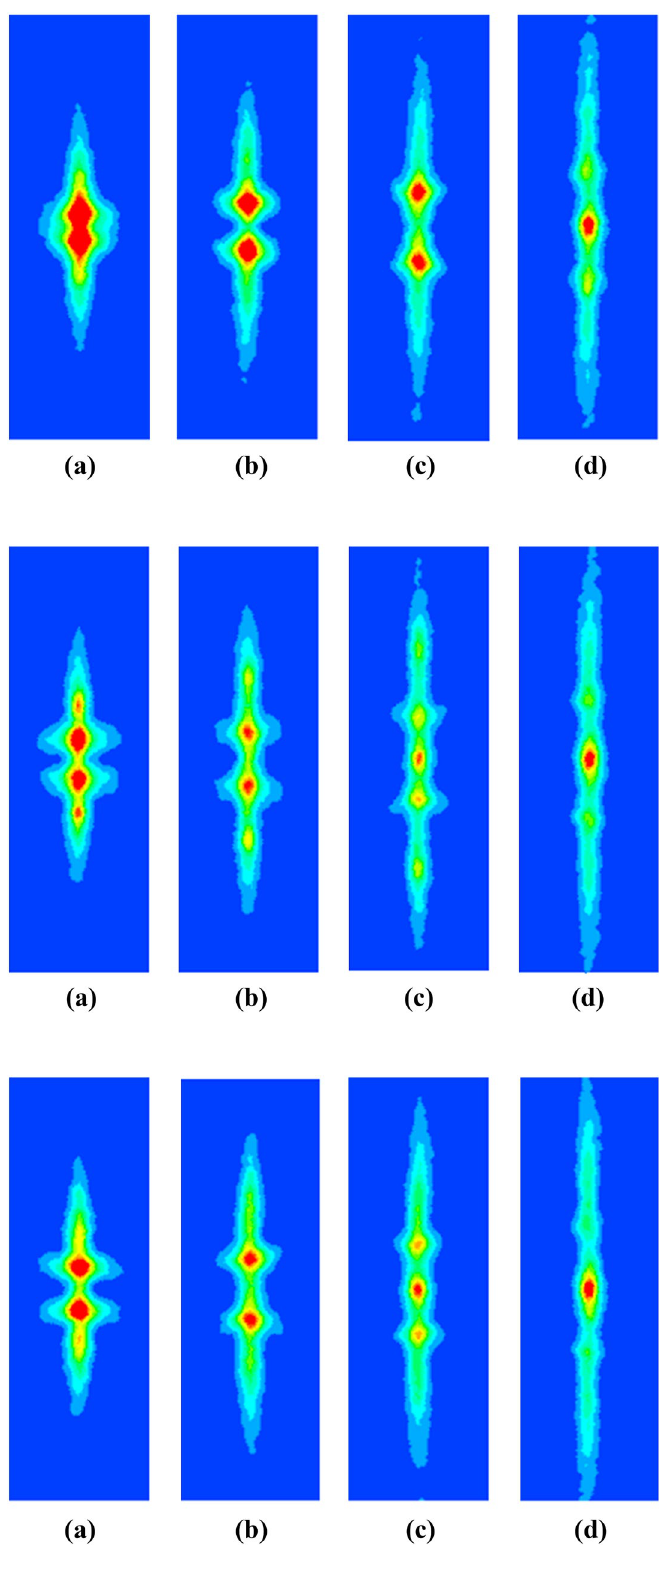
Fig. 7 Coating thickness contours for different θ when